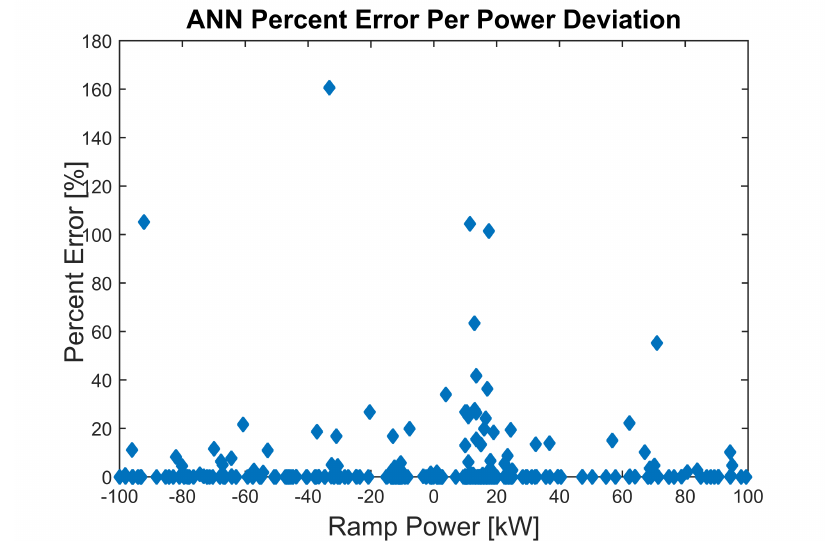
Figure 10. Percent error and ramp power of τ prediction for the ANN algorithm using a 500 run validation